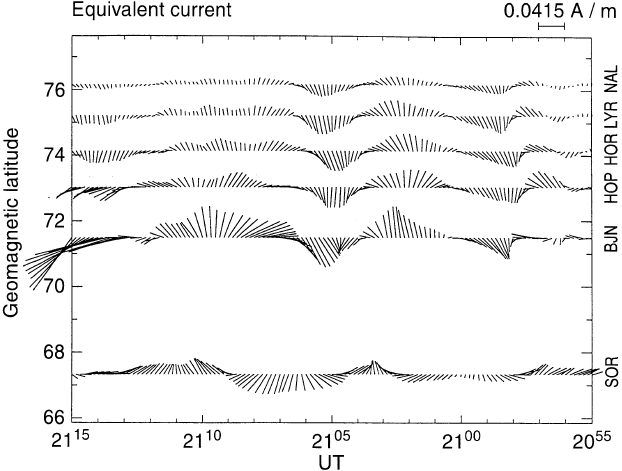
Fig. 7. Equivalent current patterns deduced from IMAGE magne- tometer data. The current vectors have been plotted versus an inverted time axis. This is appropriate for visualising eastward moving features. The time series at HOP has been shifted by 40 s to account for the